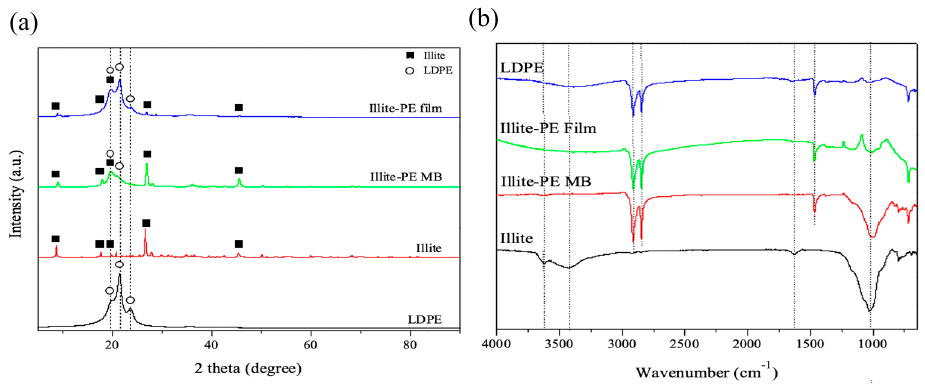
Figure 2. ( a ) XRD and ( b ) FT-IR spectra of illite, iliite-PE masterbatch, and iliite-PE film.